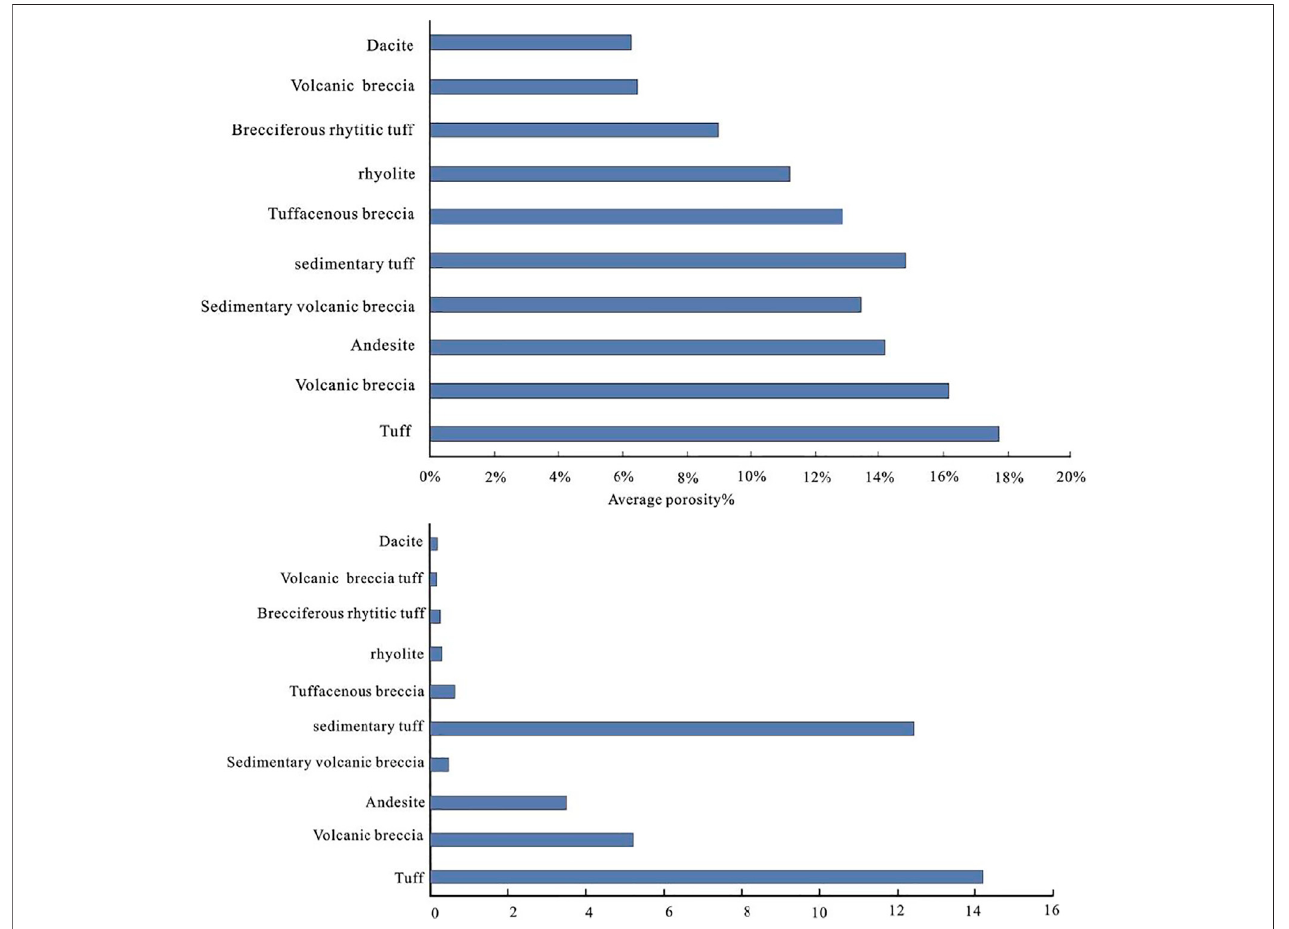
FIGURE 13 | Average values of porosity and permeability for different lithology of the Mesozoic in the D Oil fi eld.